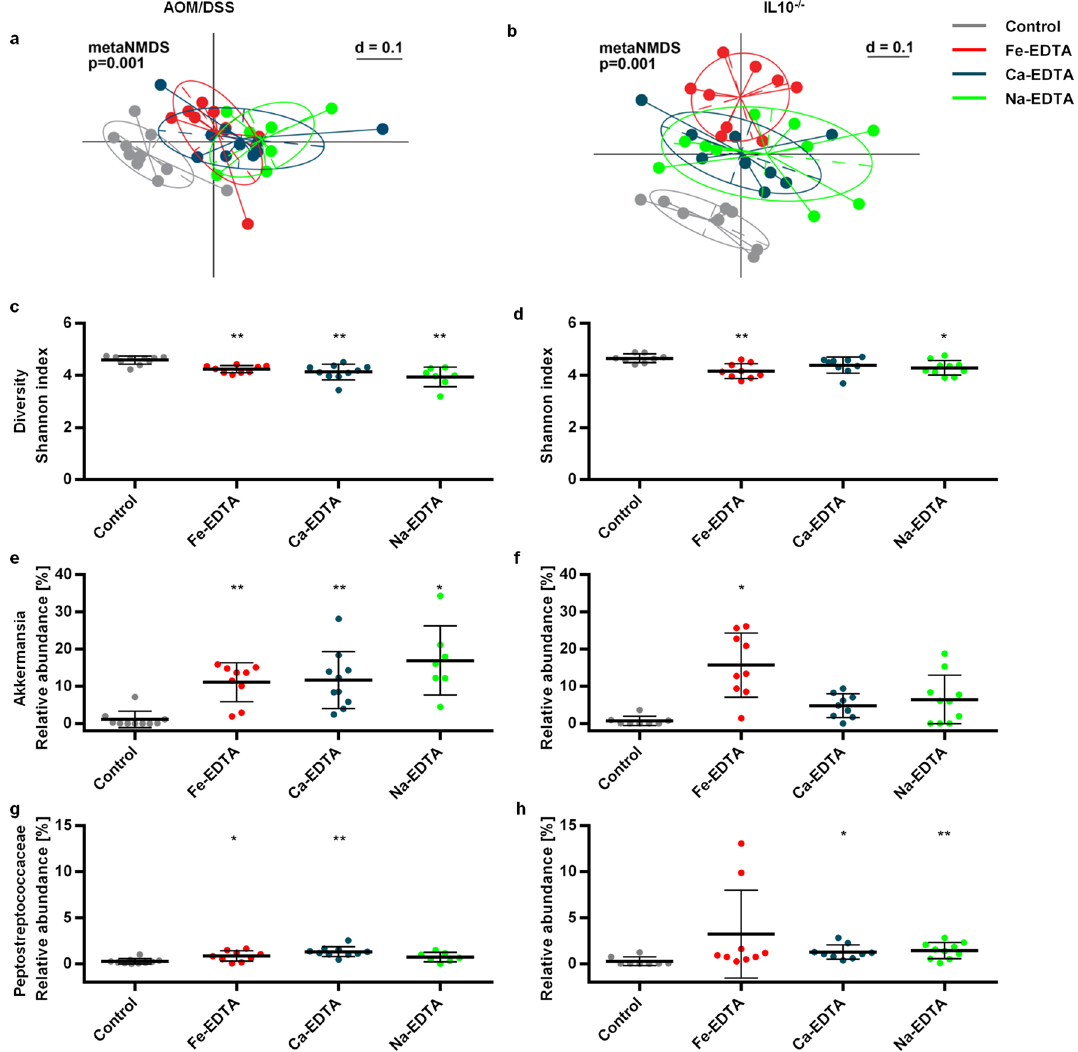
Figure 4. EDTA compounds induce dysbiosis in both the AOM/DSS and IL10 −/− models. (a , b ) Meta-NDMS plots demonstrating significantly different microbial composition in control animals versus EDTA-treated animals in the AOM/DSS ( a ) and IL10 −/− model ( b ). ( c,d ) Shannon index as a measure of microbial diversity in the AOM/DSS ( c ) and IL10 −/− model ( d ). ( e–j ) Relative abundance of the most abundant and